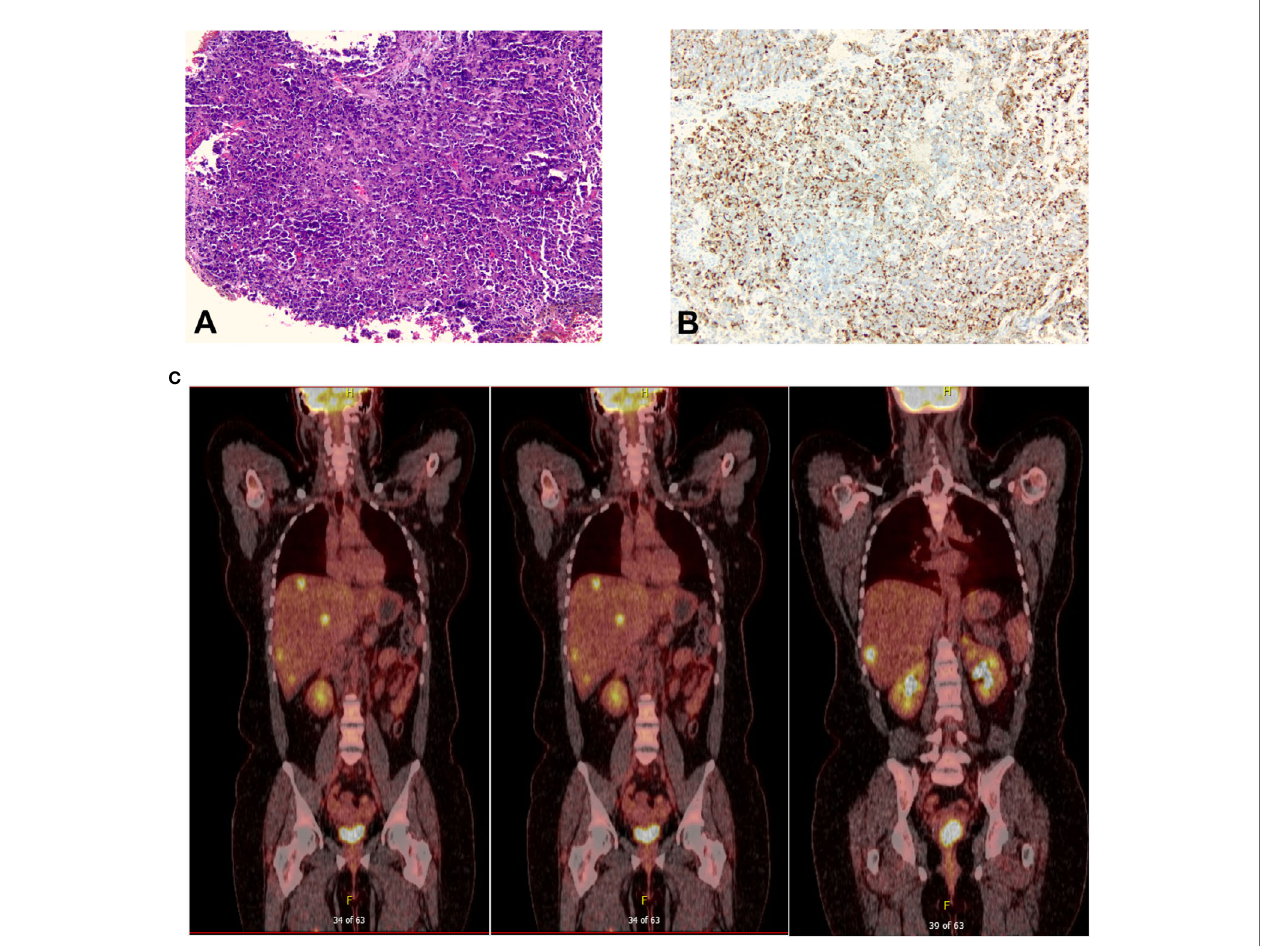
and synaptophysin (not pictured). (C) Positron Emission Tomography/Computed Tomography (PET/CT) scan at the time of diagnosis that showed evidence of cervical disease, multiple hepatic metastases, and right adrenal gland